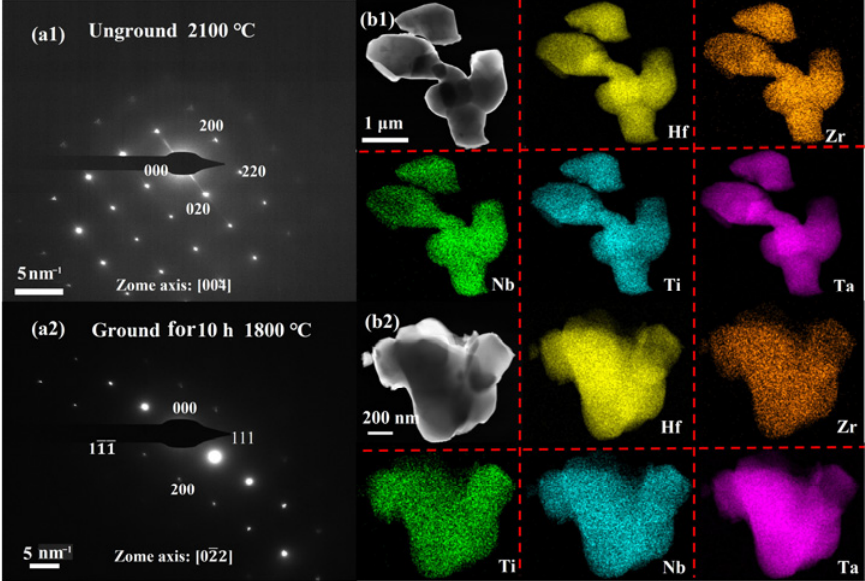
Fig. 4 (a1, a2) Electron diffraction images of selected area and (b1, b2) mapping images of high-entropy (HfZrTiNbTa)N powders synthesized from raw material mixtures unground and sintered at 2100 and from raw material mixtures ground ℃ for 10 h and sintered at 1800 , respectively.